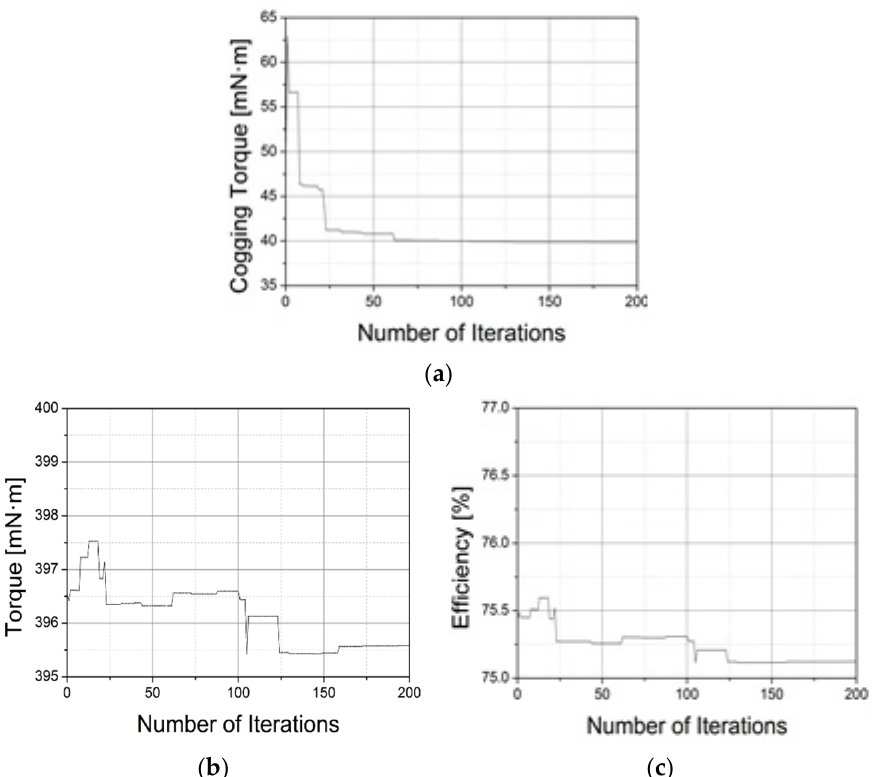
Figure 8. Convergence progress of the objective functions and constraints ( a ) cogging torque ( b ) torque ( c ) efficiency.